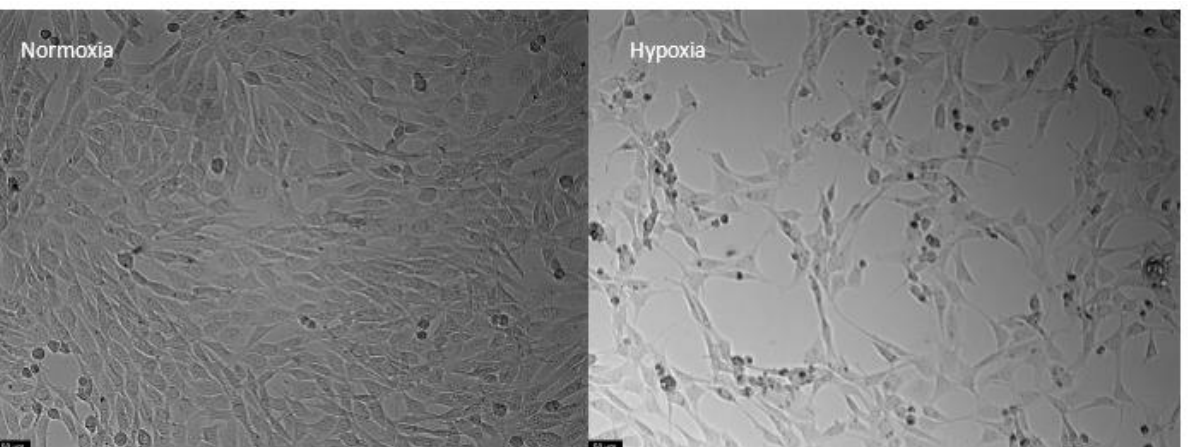
Figure 8. Representative images of HT-22 cells submitted to normoxia ( left ) and hypoxia ( right ) conditions for 48 h. Images of cell morphology were obtained using a Leica microscope equipped with Leica LAS X imaging software v3.7.4 (Leica Microsystems, Wetzlar, Germany). Scale bar: 50 µm.